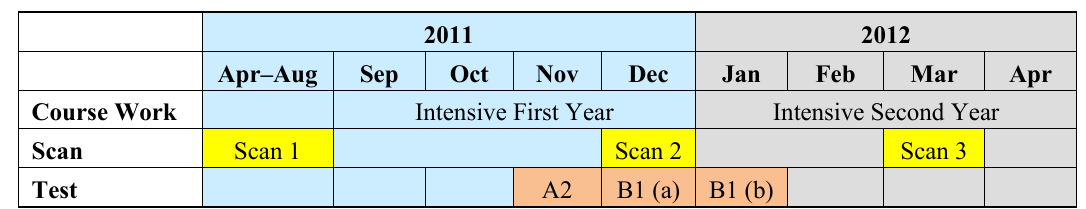
Table 1. Time table of fMRI scans and proficiency